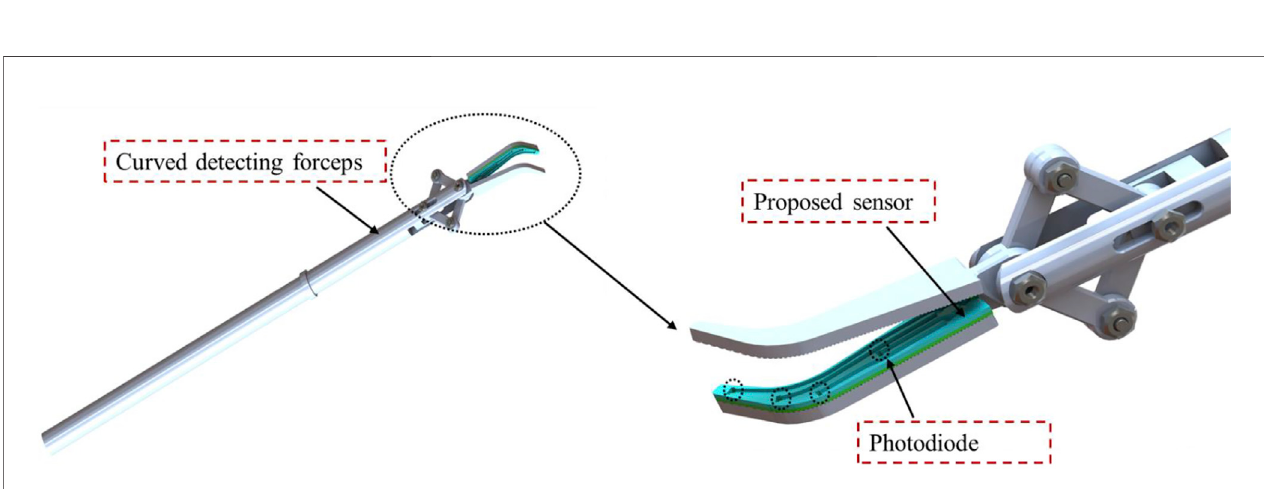
intensity in dynamic and static tests under the same pressure.